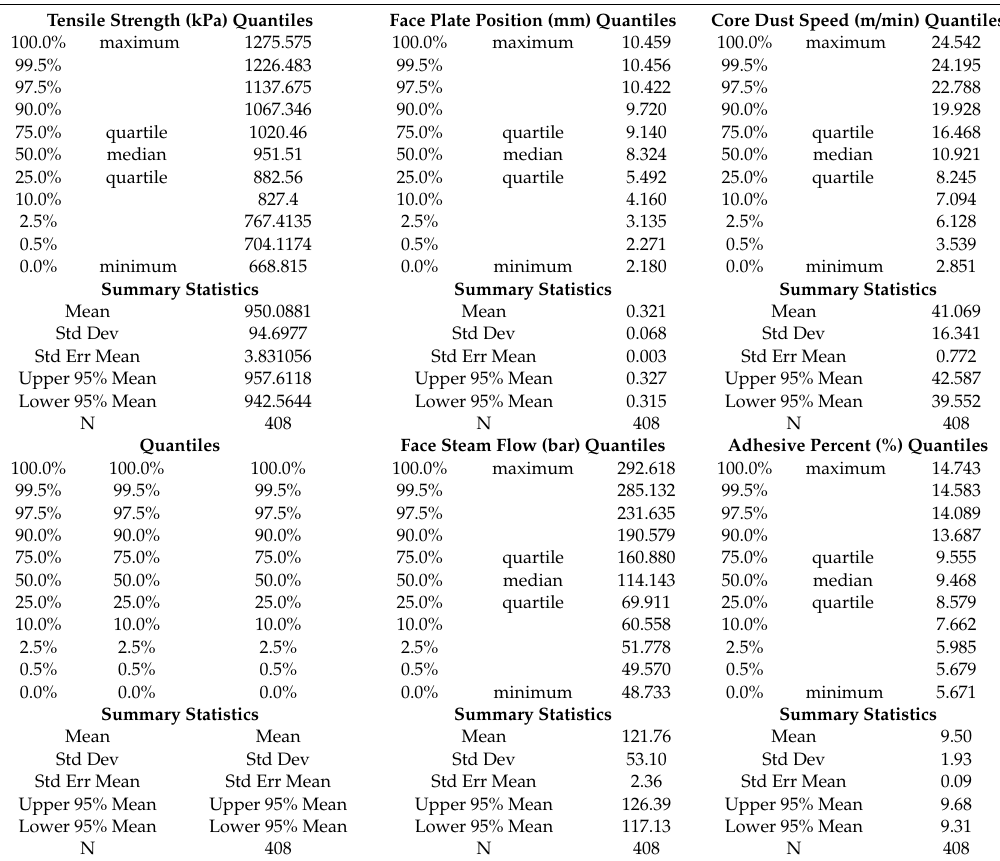
Table 4. Descriptive statistics for the dependent and independent variables in the regression tree (RT) model for